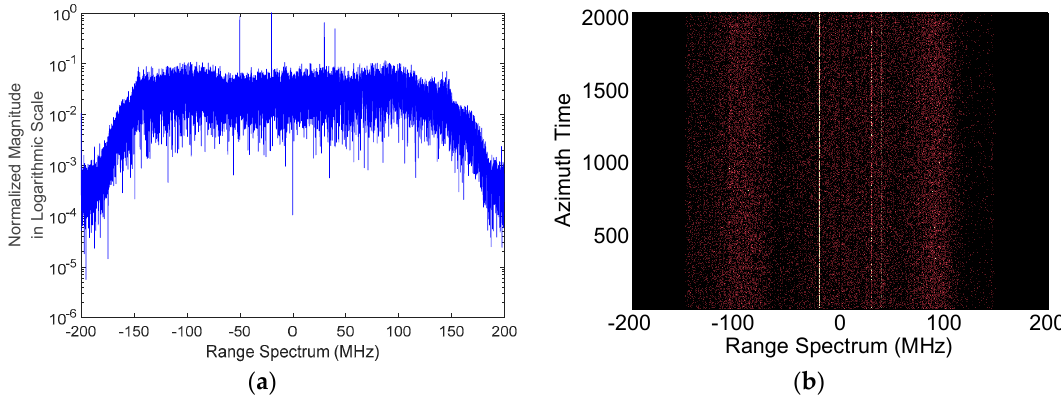
Figure8. Illustrationofnarrow-bandinterferencein( a )rangespectrumand( b )rangespectrum-azimuth– Figure 8. Illustration of narrow-band interference in ( a ) range spectrum and ( b ) range spectrum- time azimuth–time representation.